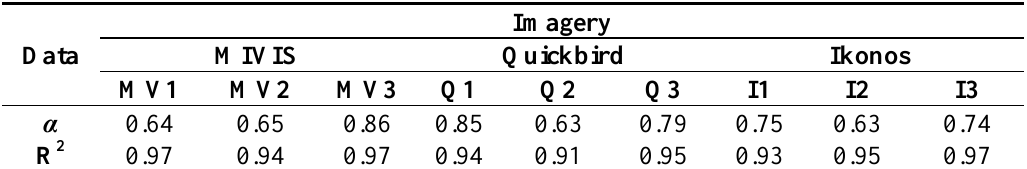
Table 2. Asphalt line angular coefficients.